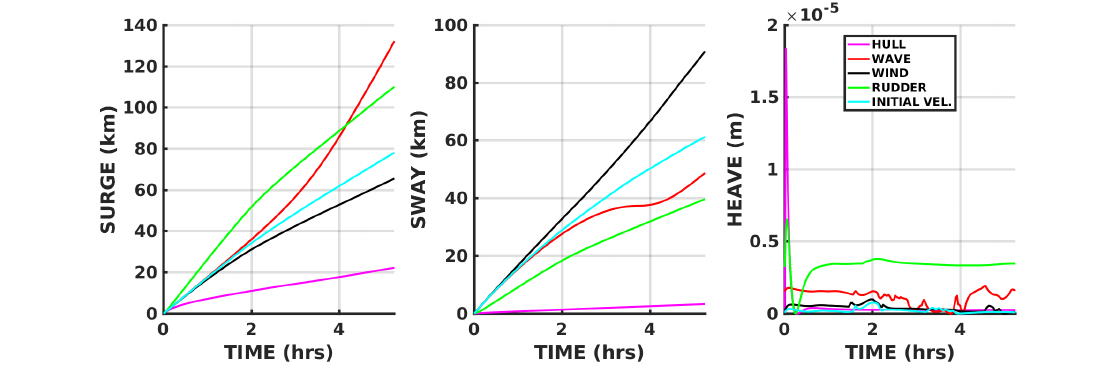
Figure 4. Translational movements performed by the ship.